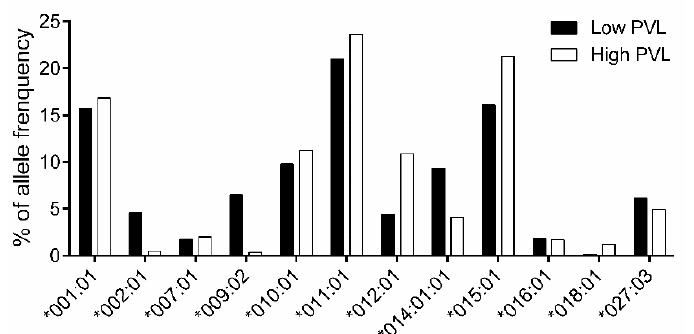
Figure 4. Comparison of BoLA-DRB3 allele frequencies between LPVL and HPVL cows. BoLA-DRB3 allele frequencies in LPVL and HPVL cows. The 611 asymptomatic cows comprised 317 LPVL and 294 HPVL individuals. The allele frequencies were calculated in LPVL ( ■ ) and HPVL cows ( □ ) for each BoLA-DRB3 allele (Table S6). Total of 12 out of 26 alleles with frequency > 1% are shown. Table 5. Fisher’s exact test based association analysis of BoLA-DRB3 alleles in low PVL and high PVL cows.